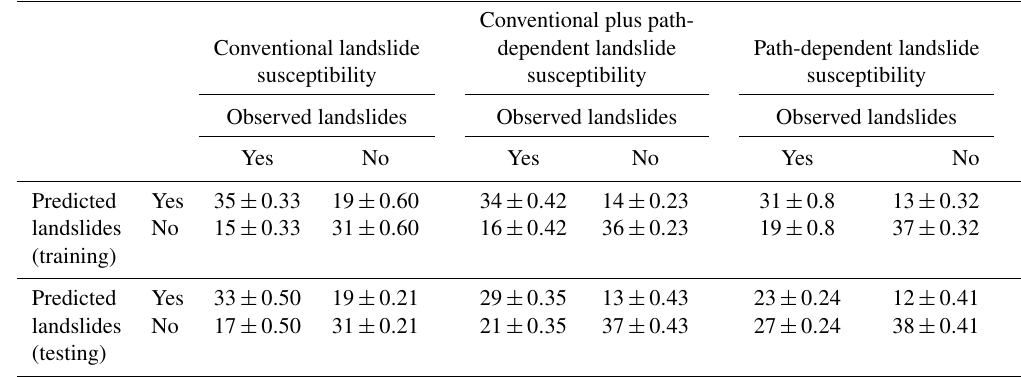
Figure 8. Conventional landslide susceptibility map (a) , the conventional plus path-dependent landslide susceptibility map (averaged out over 16 time slices) (b) and path-dependent landslide susceptibility map (averaged out over 16 time slices) (c) . The pie charts show the percentage of pixels in each map in different probability levels of landslide occurrence. Table 3. Contingency tables computed with cut-off value of 0.5 for the three models. The numbers in the table represent the average values computed in the 10 training and 10 testing